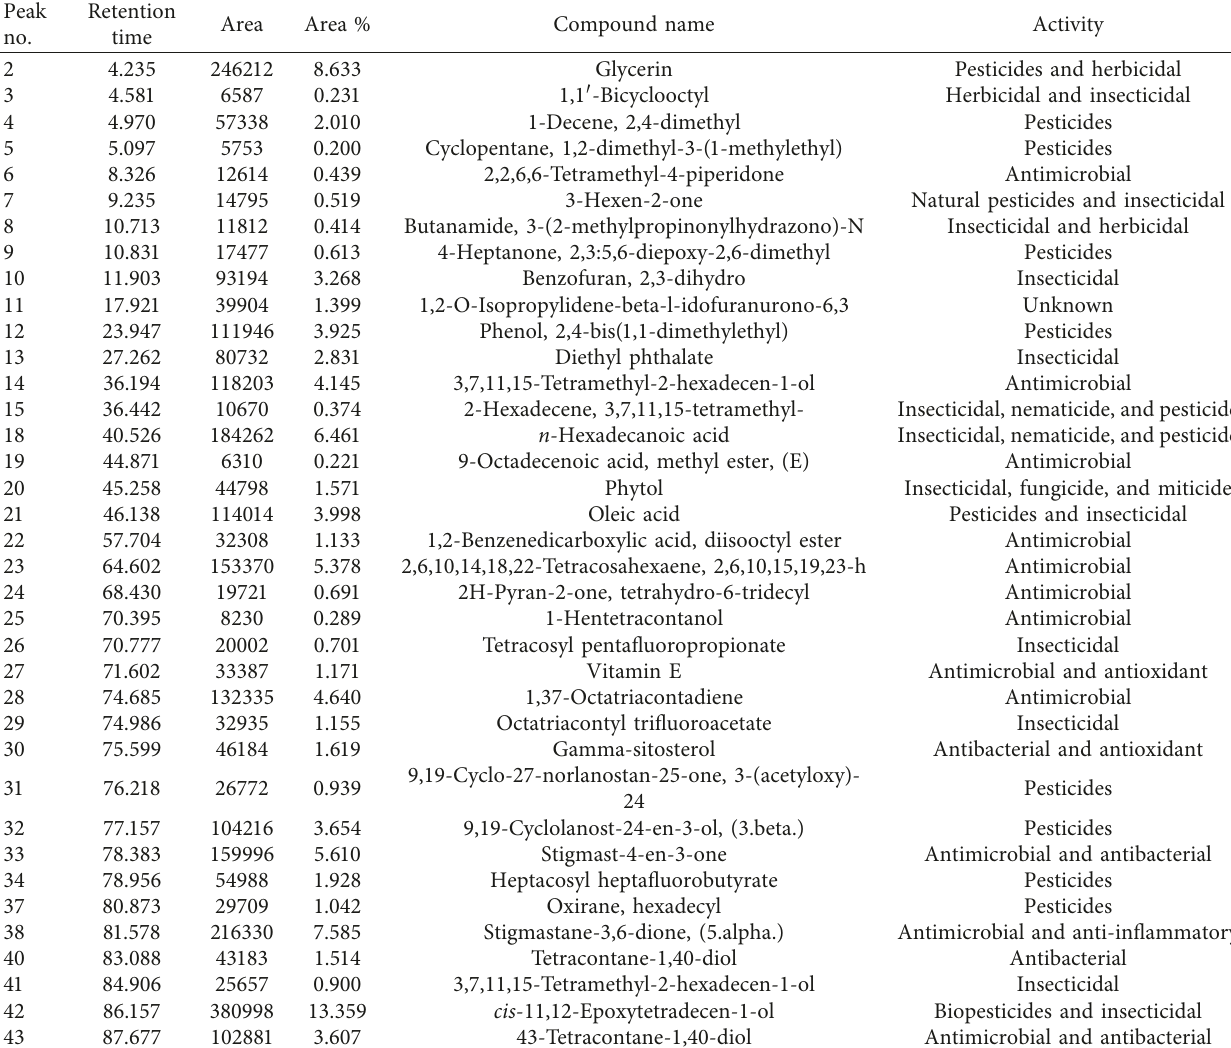
Table 2: Chemical compositions in acetone extract of Azolla pinnata